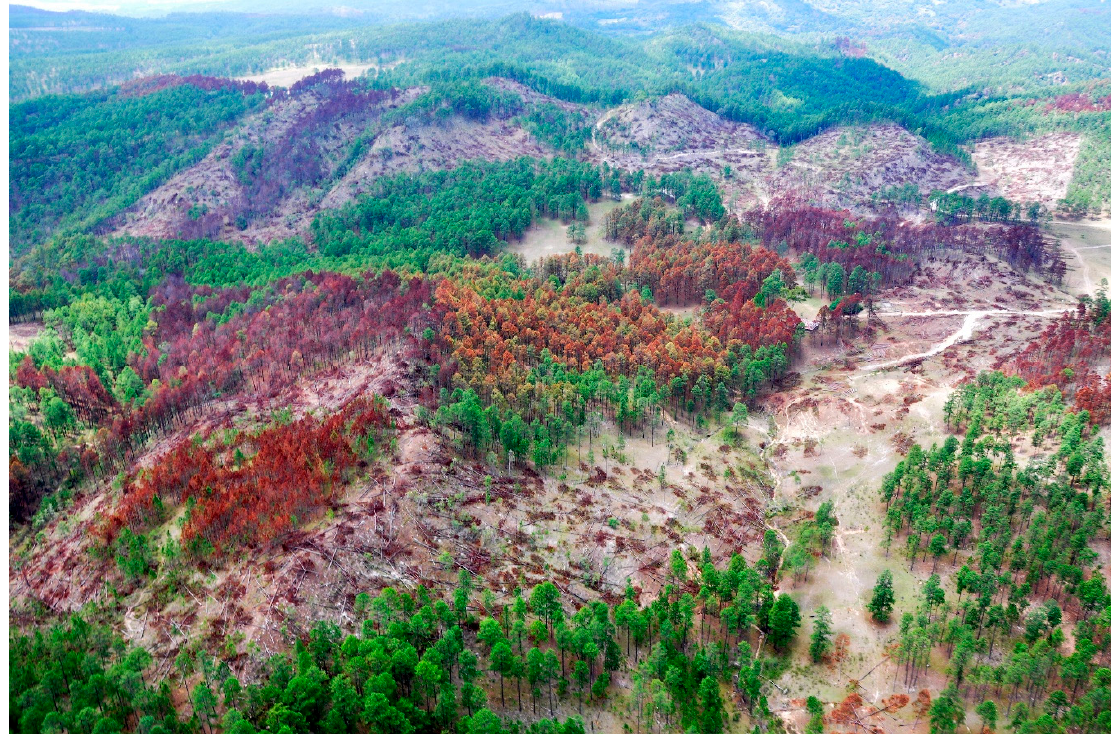
Figure 2. Cut-and-leave control method applied in Honduras during the 2015 southern pine beetle (SPB) outbreaks. Photo by Ronald Billings.